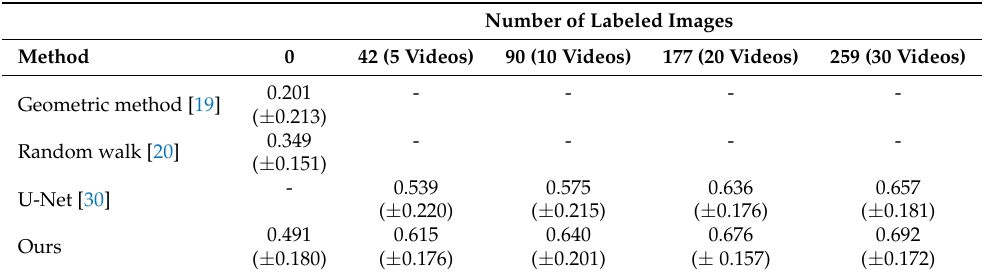
Table A2. Results of shadow detection for the validation dataset evaluated in the DICE score. The scores are calculated for each validation image, and means over them are shown. The numbers in parentheses are the standard deviations.